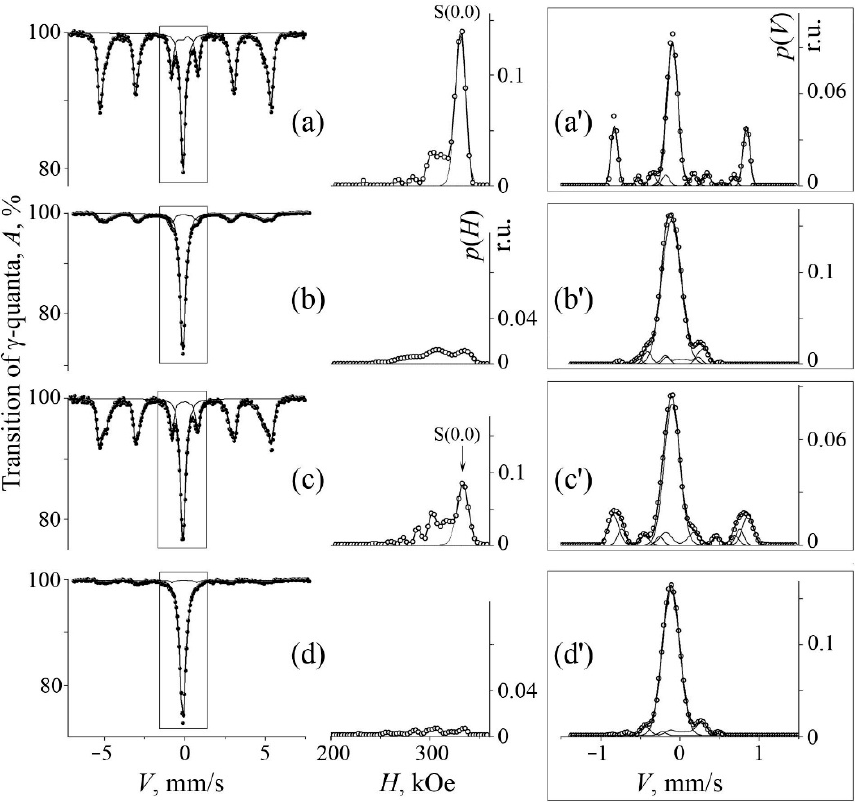
Figure 5. Mössbauer data of the MA samples after BM and annealing of Series B : ( a – d ) distributions of the p ( H ) of the sextet for the α phase; ( a’ – d’ ) distributions of the p ( V ) of the center of the spectra. Treatment, composition: ( a , a’ ) BM, annealing at 700 °C, 1 h, composition 4 (Fe–4.7Cr + 10% Mn 2 N); ( b , b’ ) BM, annealing at 800 °C, 1 h, composition 4 (Fe–4.7Cr + 10% Mn 2 N); ( c , c’ ) BM, annealing at 700 °C, 1 h, composition 5 (Fe–8.6Cr + 10% Mn 2 N); ( d , d’ ) BM, annealing at 800 °C, 1 h, composition